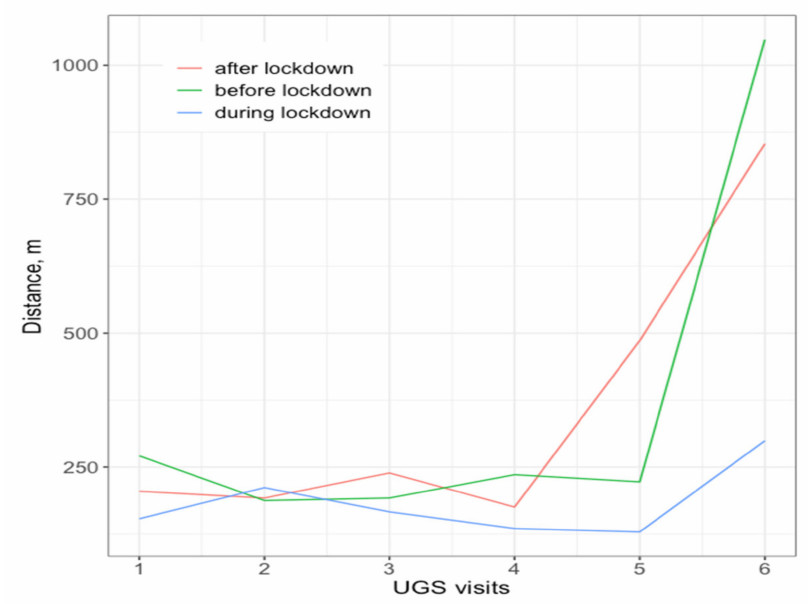
Figure 17. UGS visitation by survey respondents (1—every day, 2—> once a week, 3—several times in a month, 4—once a month, 5—< once a month,